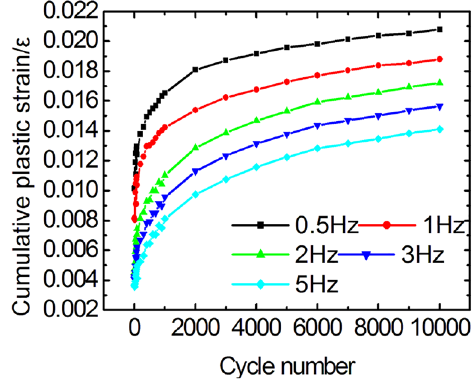
Fig. 11 Influence of the temperature on the cumulative plastic strain